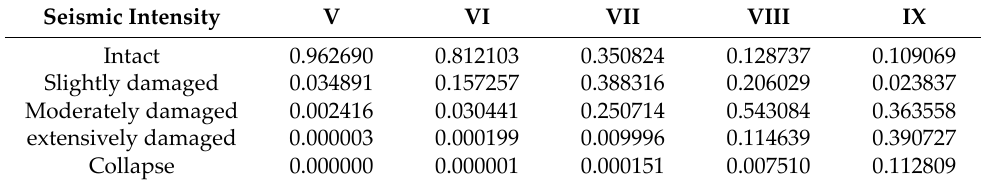
Table 3. Correspondence table between seismic intensity and PGA. Table 4. Damage probability matrix for different earthquake intensities.